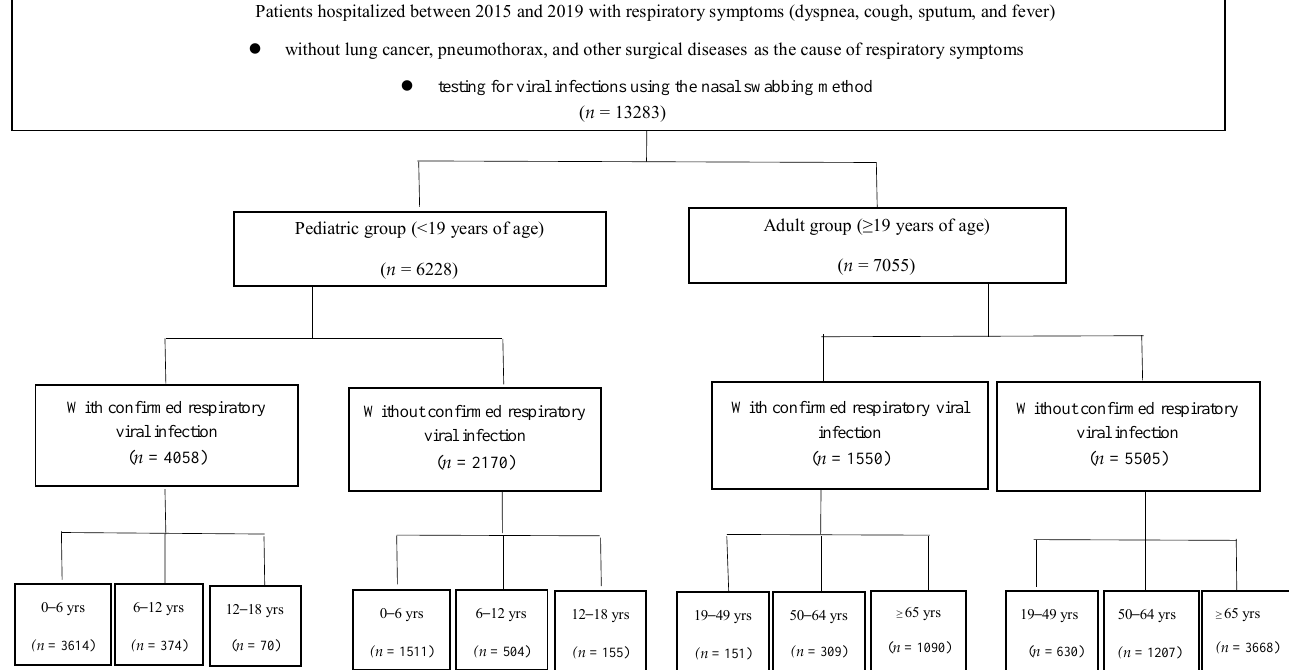
Figure 1. Enrollment and grouping of study patients, according to inclusion and exclusion